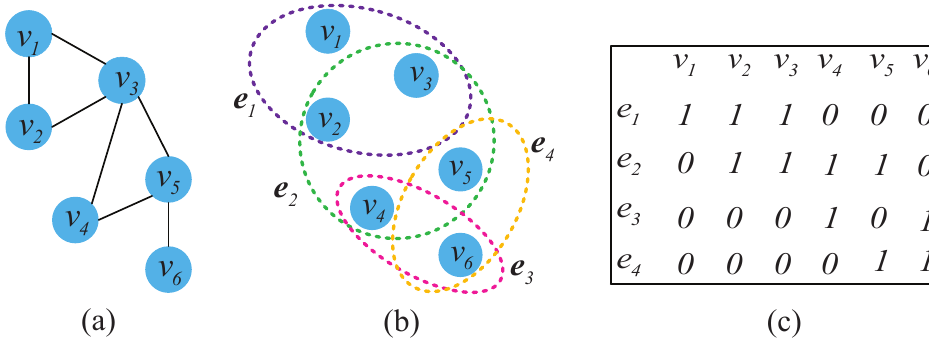
Figure 1. An example for hypergraph: ( a ) simple graph; ( b ) hypergraph; and ( c ) incidence matrix H